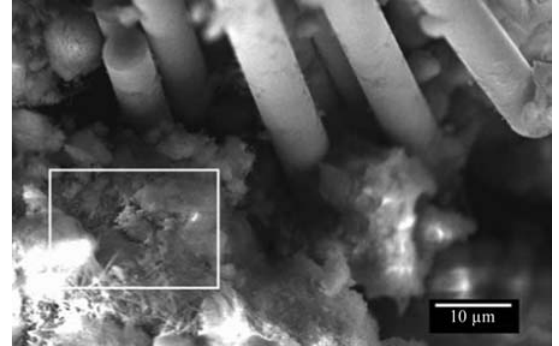
Figure 6 SEM micrograph of the air bubble near the interface of specimen S5 after the pull-out test. Figure 8 SEM micrograph of the interface (specimen S2).